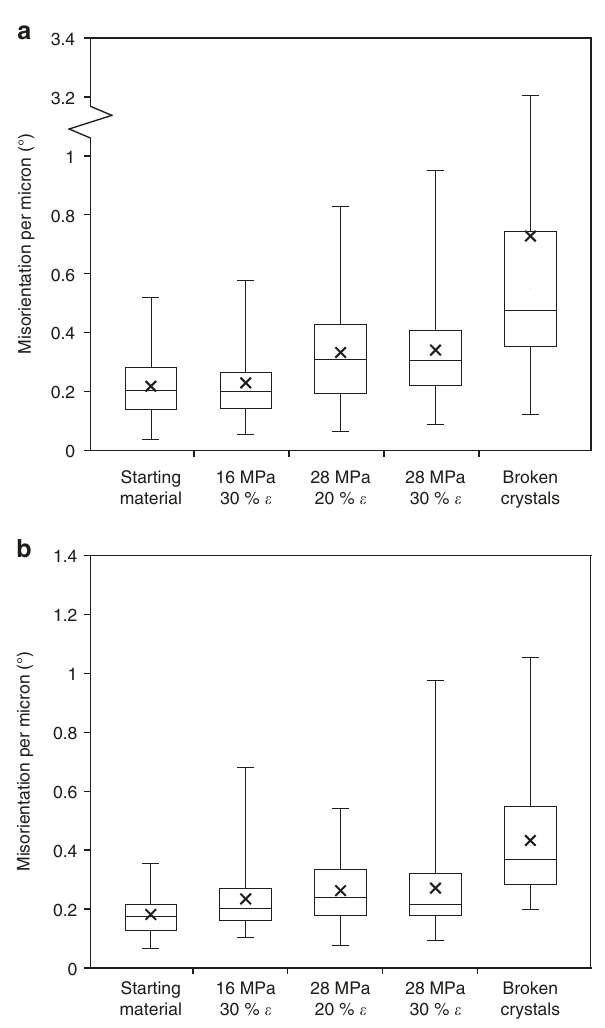
Fig. 6 Box-plot of deformation intensity across sample sets. The spread in misorientation per micron (simply the lattice distortion (in degrees) divided by the crystal length (in microns)) for a COLB2 and b COLLAH4. This shows the maximum, minimum (the top and bottom ends of the vertical lines), median (the central horizontal line), the 25th and 75th percentiles (the bottom and top of the boxes, respectively) and mean (crosses) of the values for the starting material, each stress and strain ( ε ) condition and the broken microlites. Using the misorientation per micron allows us to exclude any bias that would result from comparing microlites of different sizes